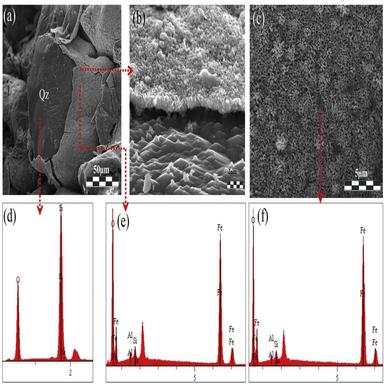
Photomicrograph obtained by MEV and chemical analysis by EDS (sample RP.R.03/14: FSS from the banks of the Pedreira River): the quartz grain (Qz) in the image (a) was confirmed by SEM/EDS analysis with (d) an Fe oxide film (b) that was, according to the EDS spectrum, interpreted as corresponding to ferric goethite.